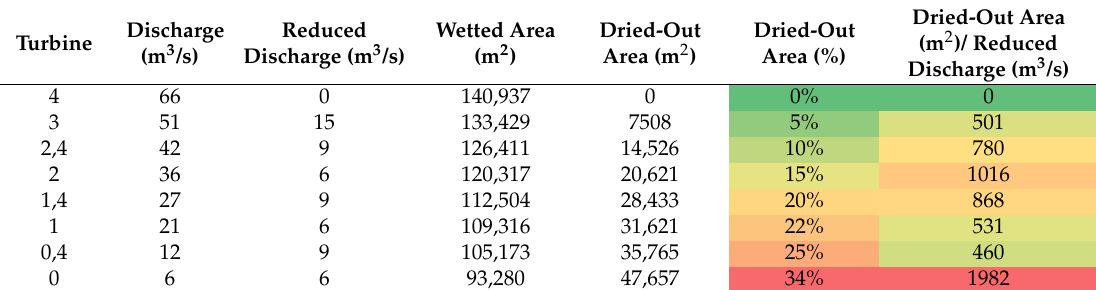
Table 4. Number of working turbines for different scenarios, its correspondent discharge and reduced discharge, the wetted area associated, dried-out area, percentage of dried-out area and marginal dried-out area per reduced